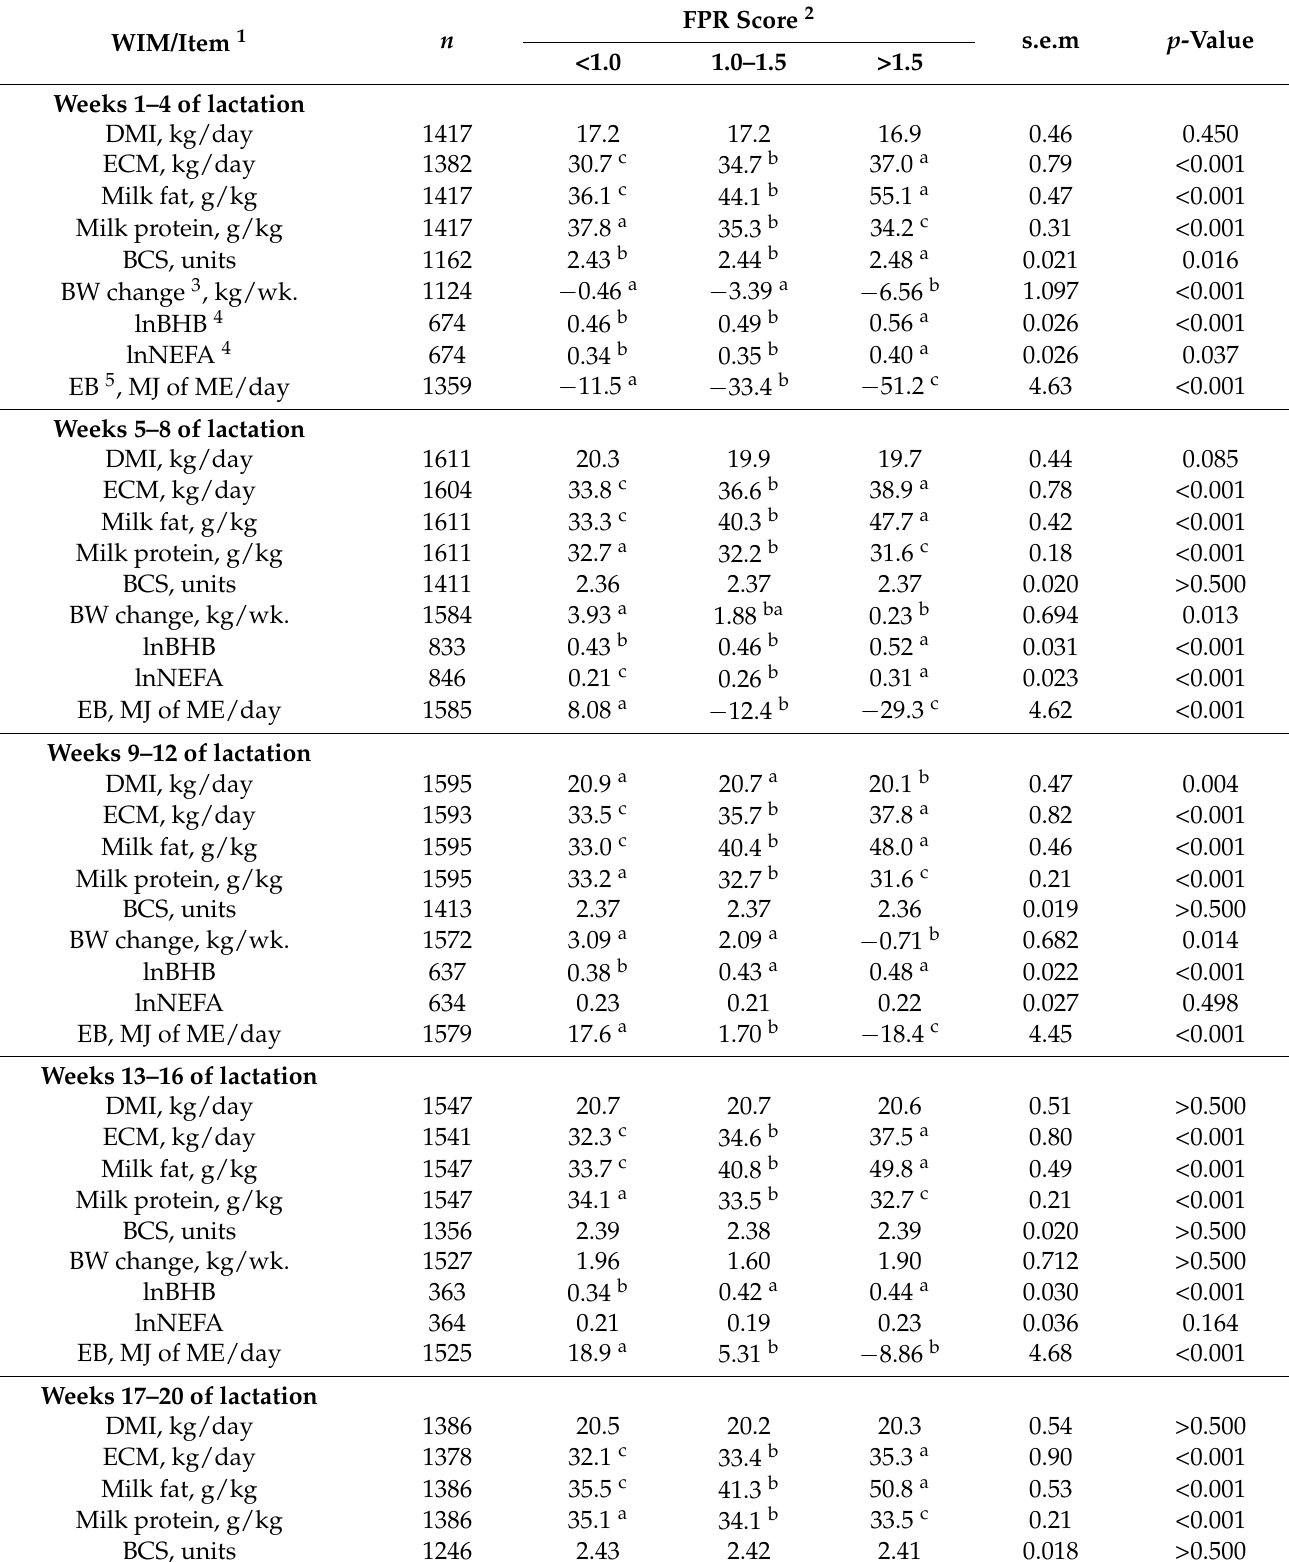
Table 5. Performance indicators and blood metabolites (adjusted least squares means: 4 wk intervals) of second lactation Holstein-Friesian dairy cows within three fat-to-protein ratio scores in milk during early lactation (1–20 WIM). WIM/Item